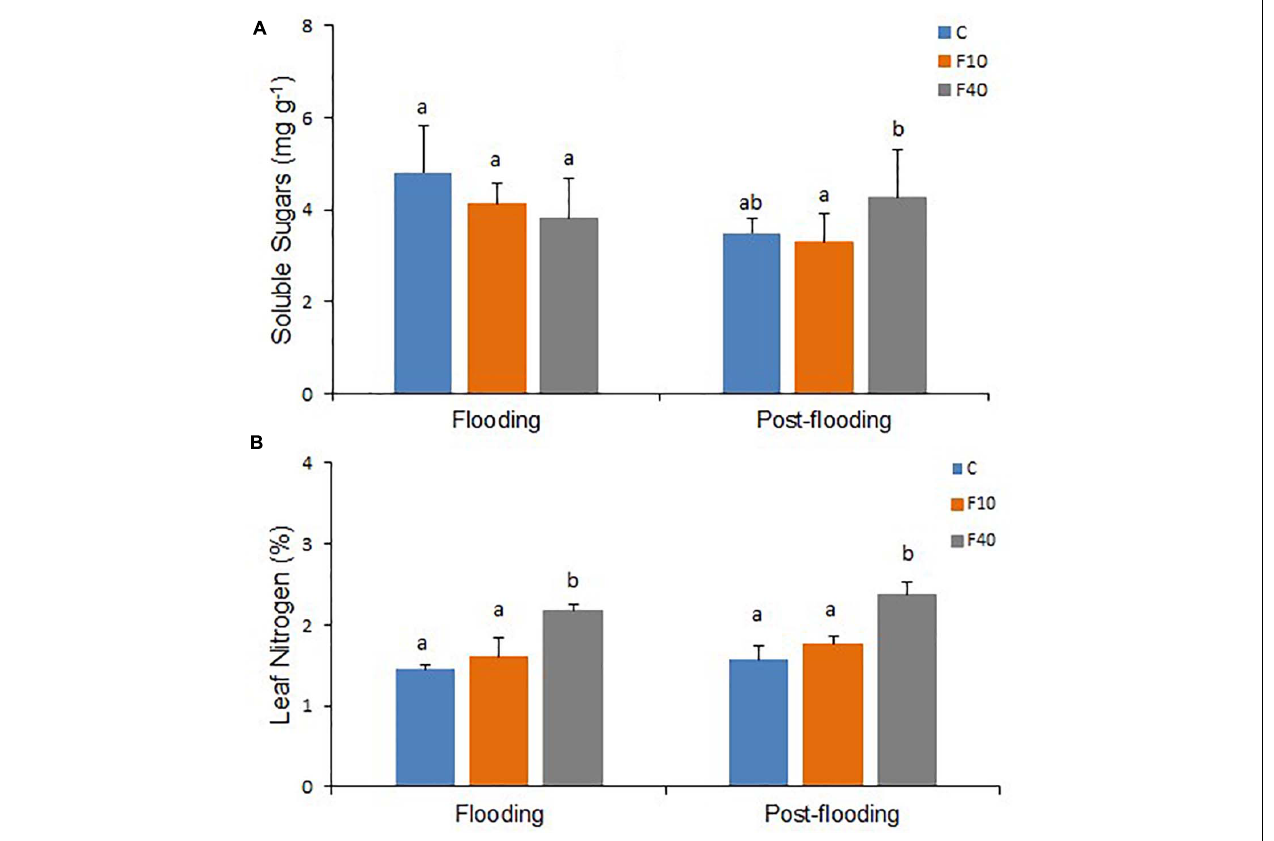
FIGURE 5 | Soluble sugars content ( A , N = 5) and nitrogen content (N, B , N = 3) on fully expanded leaves after 35 days of flooding, and at the end of the post-flooding recovery period (Day 63). Means followed by the same letter did not differ according to Tukey’s test ( p < 0.05). Vertical bar: standard deviation.